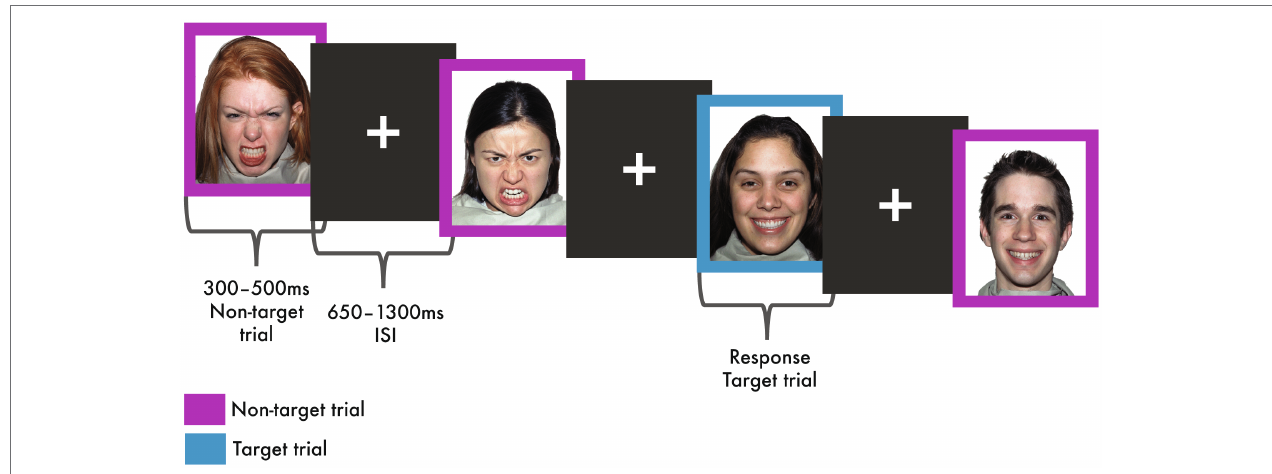
FIGURE 1 | Implicit emotional faces task. During all the trials, participants attended to the colour of the border and ignored the emotional content of the faces. The non-target trials comprised 75% of the trials (shown here in purple). Target or ‘catch’ trials were presented randomly, comprising 25% of trials (shown here in blue). During target trials, participants rapidly responded to their assigned border colour, in this example blue, using a button-press. Faces were extracted from the MacBrain Face Stimulus Set (http://www.macbrain.org/resources.htm), the actors presented here have been previously published (Tottenham et al.,